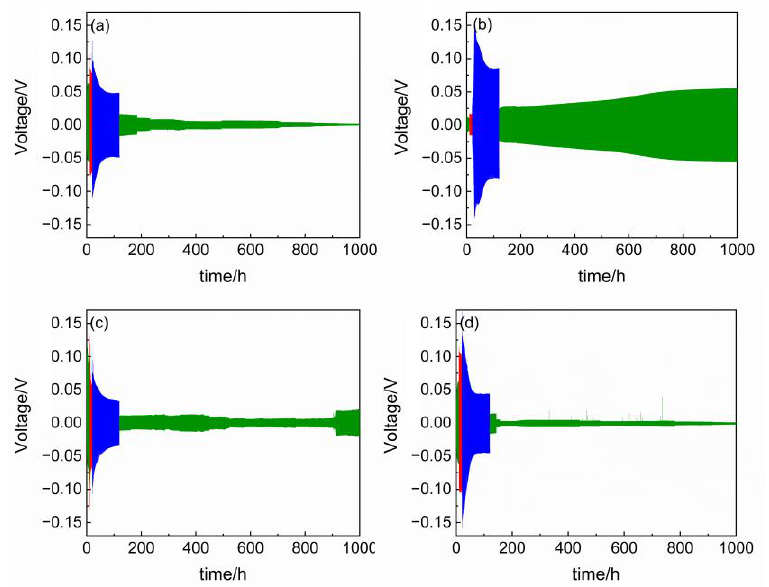
Figure 3. Deposition and stripping cycles of Li||Li symmetric cells with ( a ) LP30, ( b ) LP30-NH 4 PF 6 , ( c ) LP30-TMAPF 6 , ( d ) LP30-TEAPF 6 electrolytes at 0.125 mA cm −2 (green), 0.250 mA cm −2 (red) and 0.500 mA cm −2 (blue).